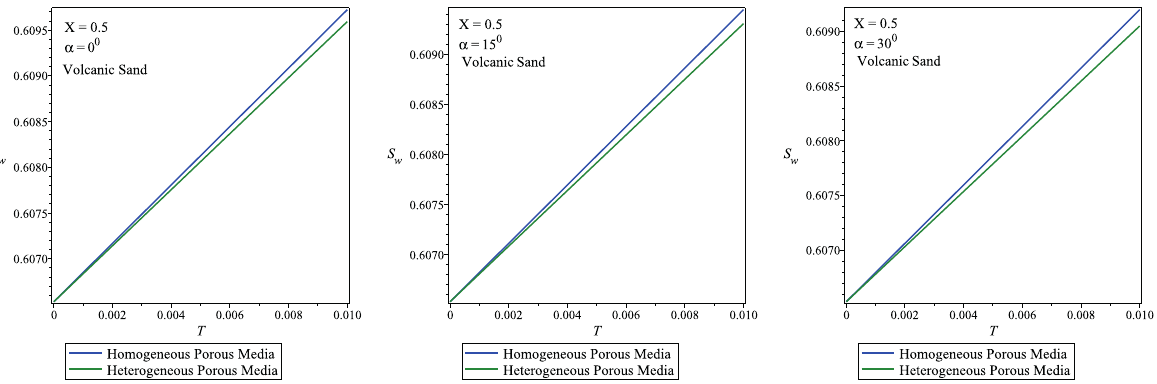
Fig. 4: comparison of saturation vs. dimensionless times for homogeneous and heterogeneous porous media in Volcanic Sand for different inclined plane α = 0 ◦ , 15 ◦ , 30 ◦